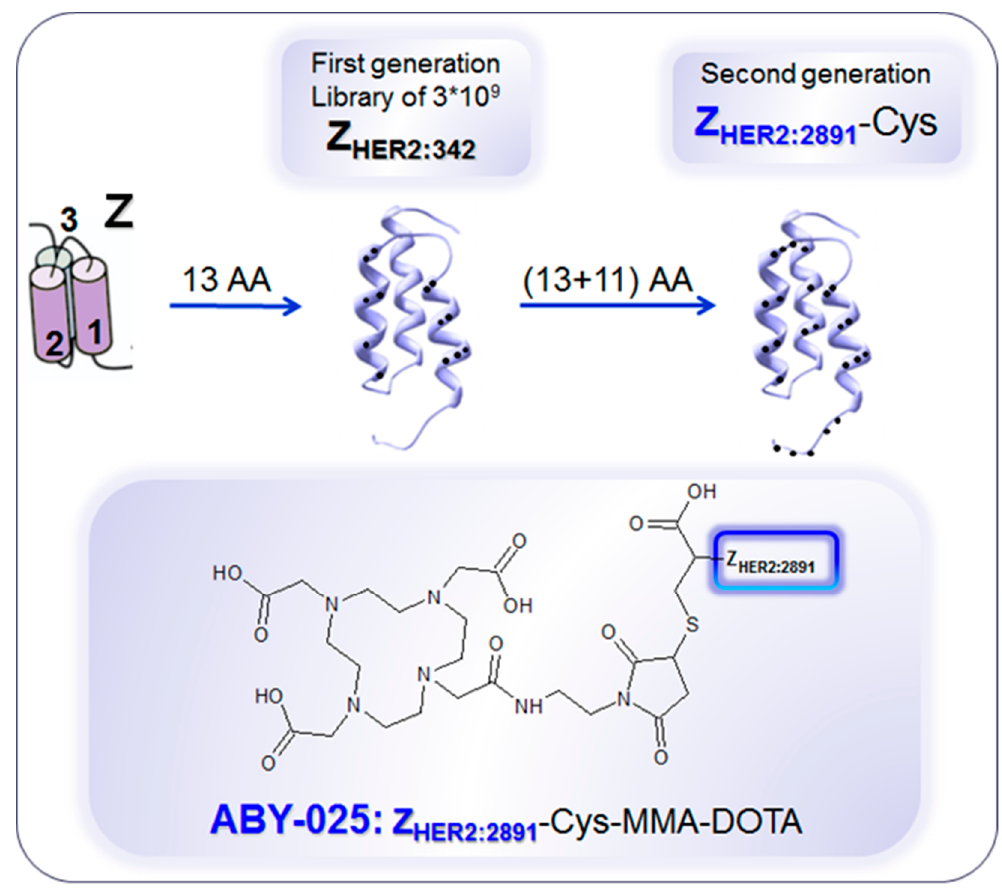
Figure 10. Development of anti-human epidermal growth factor receptor type 2 (HER2) Affibody ® molecules. The variation of 13 amino acids (AA) on the binding surface of a 3-helix peptide structure (Z) resulted in a combinatorial library containing billions of variants from which the 1st generation HER2-binding Affibody molecule, Z HER2:342 , was selected. Further modification of the non-binding surface resulted in the second generation Affibody molecule, Z HER2:2891 , with higher thermal stability and hydrophilicity, diminished background interactions with immunoglobulins and production flexibility by peptide synthesis or recombinant expression as well as fully retained in vitro and in vivo functionality. Z HER2:2891 was modified by addition of a unique terminal cysteine for site-specific conjugation to the bifunctional chelator, 1,4,7,10-tetraaza cyclododecane-1,4,7-tris-acetic acid-10-maleimidoethylacetamide (MMA-DOTA). Z HER2:2891 –Cys binds selectively to HER2 with high affinity (K D : 60 pM). Reproduced from [183].